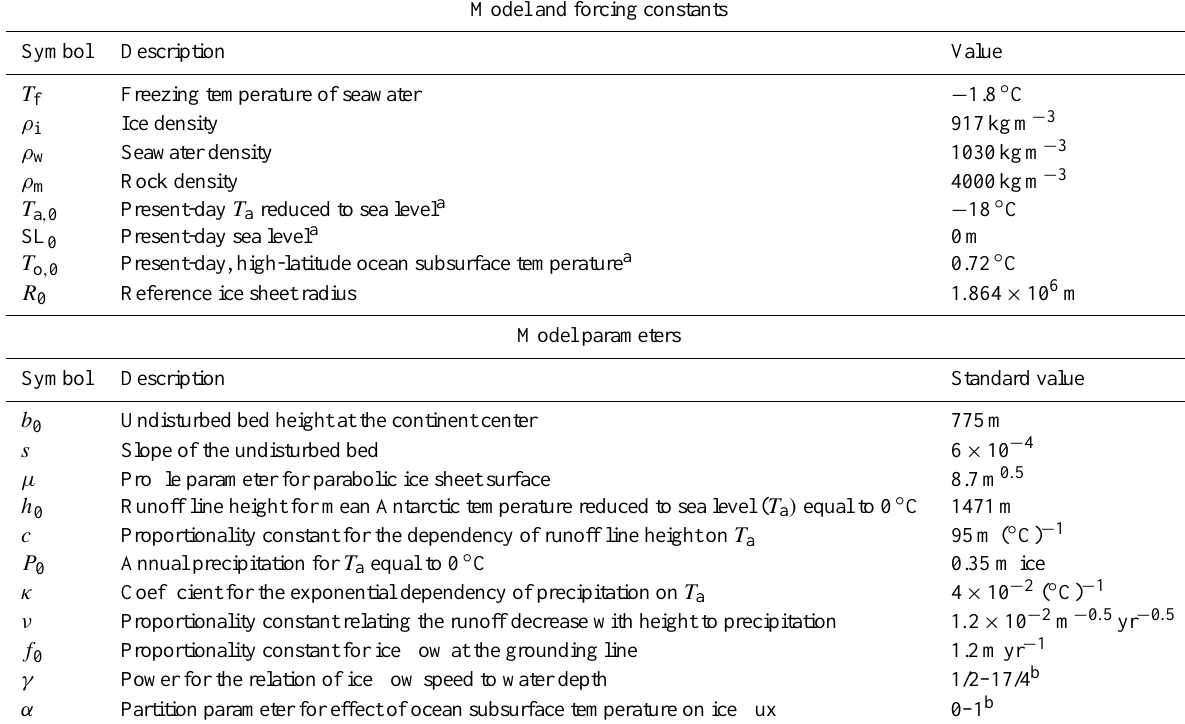
Table 1. Model constants and parameters.